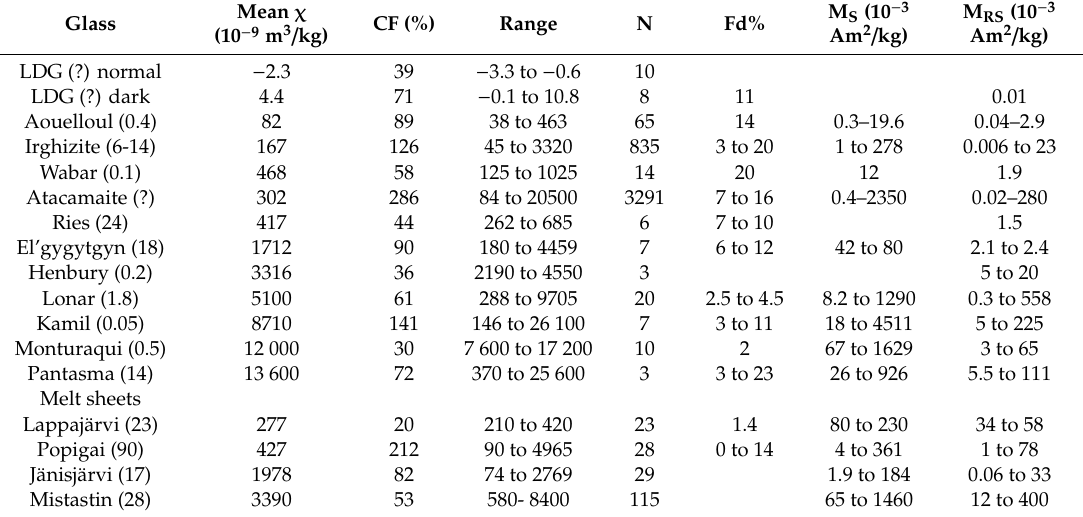
Table 3. Synthesis on magnetic properties of non paramagnetic impact glasses, after [9] complemented with data from [10–12,20,50,52,53] and this work. Sites are ordered by increasing mean susceptibility, with impact melt sheets at the end. When known the diameter in km of the source crater is indicated within brackets. N is the number of data used for mean susceptibility, and CF its coe ffi cient of variation. Fd%, M S , and M RS may rely on less